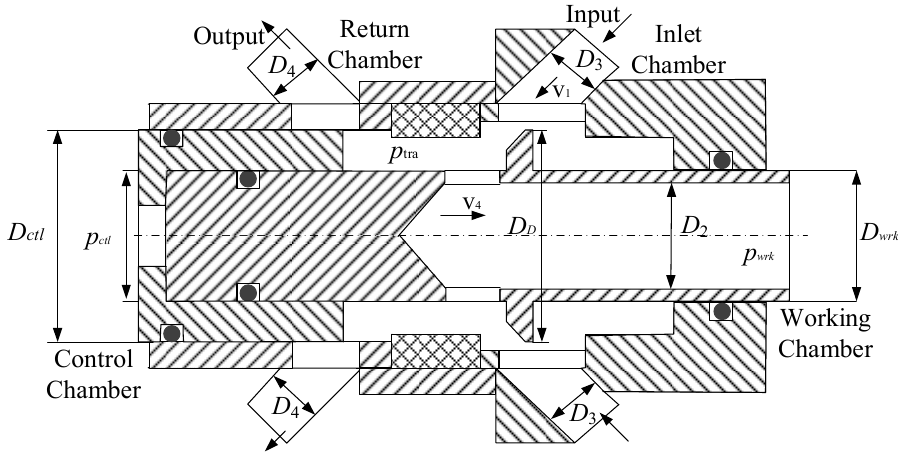
Figure 9. Schematic diagram of the differential directional valve.